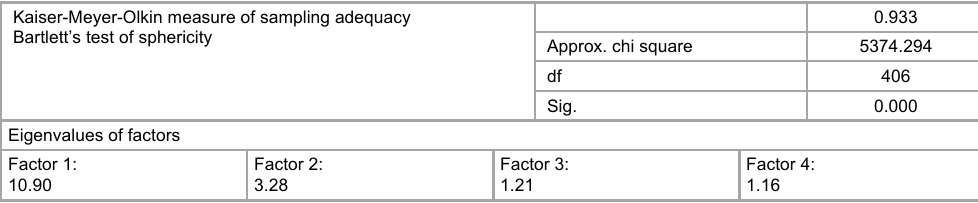
Table 3 indicates the rotated factor matrix for the treatment of employees from designated